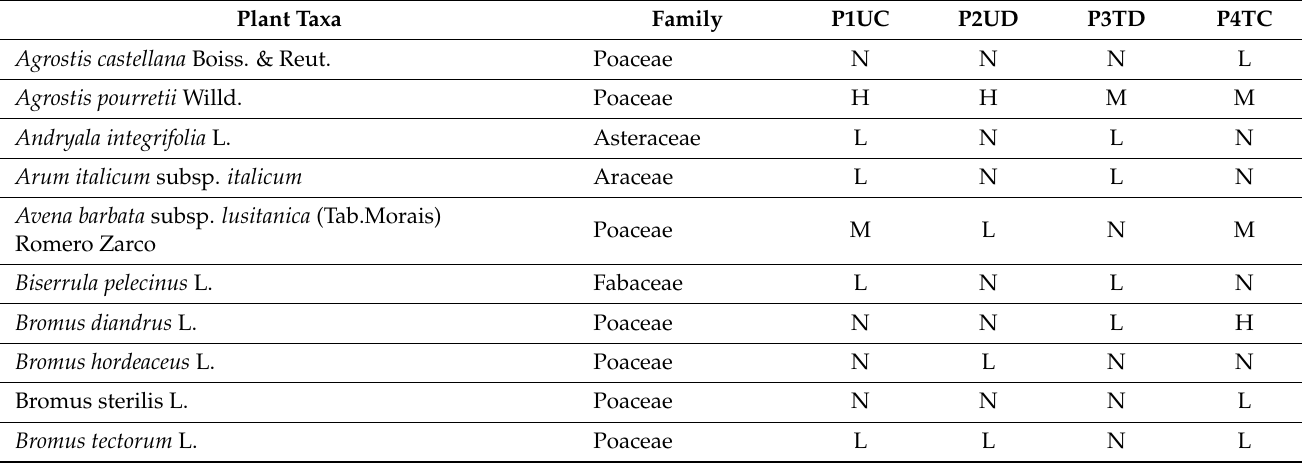
Table A3. Plant species identified in each plot, in